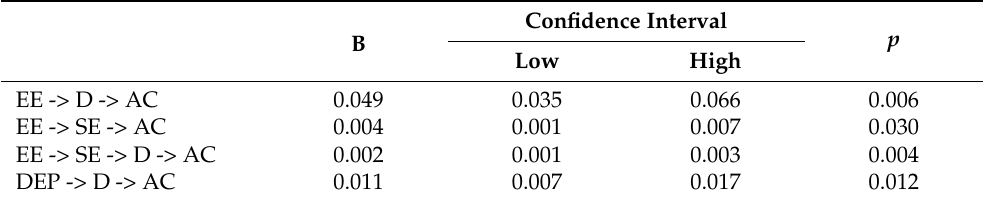
Table 2. Indirect effects of burnout and self-efficacy on alcohol consumption.